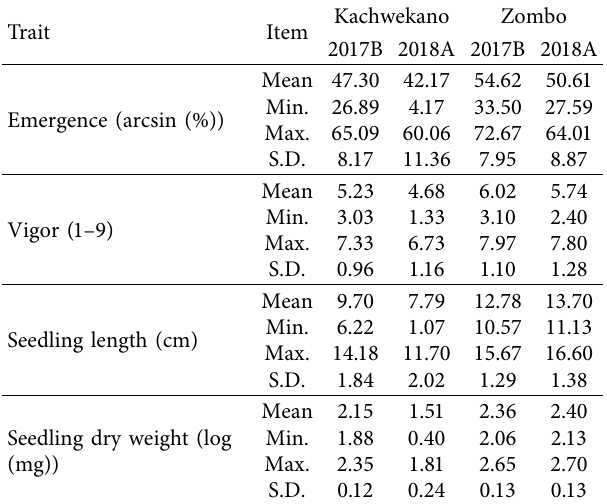
Table 5: Descriptive statistics traits for all recorded traits from field trials in the two